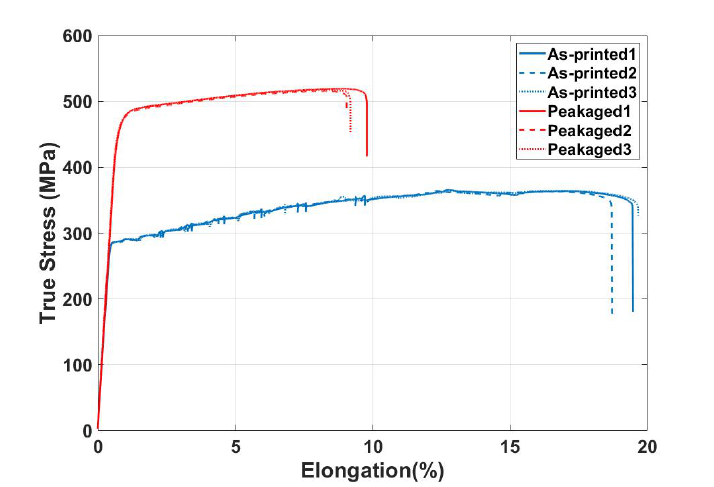
Figure 11. Tensile testing curve for as-printed (blue) and peak-aged (red) conditions for Al-Mg-Sc-Zr alloy. The curve is represented as an elongation (%) vs. true stress (in MPa) curve. Table 4. Summary of tensile properties for Al-Mg-Sc-Zr alloy in as-printed and peak-aged condi- tions. Values are averaged over three test samples. σ 0.2 and σ UTS represent the yield strength and ultimate tensile strength, respectively. Standard deviation for σ 0.2 = 1.2 MPa, σ UTS = 1.0 MPa and area reduction = 0.23%.